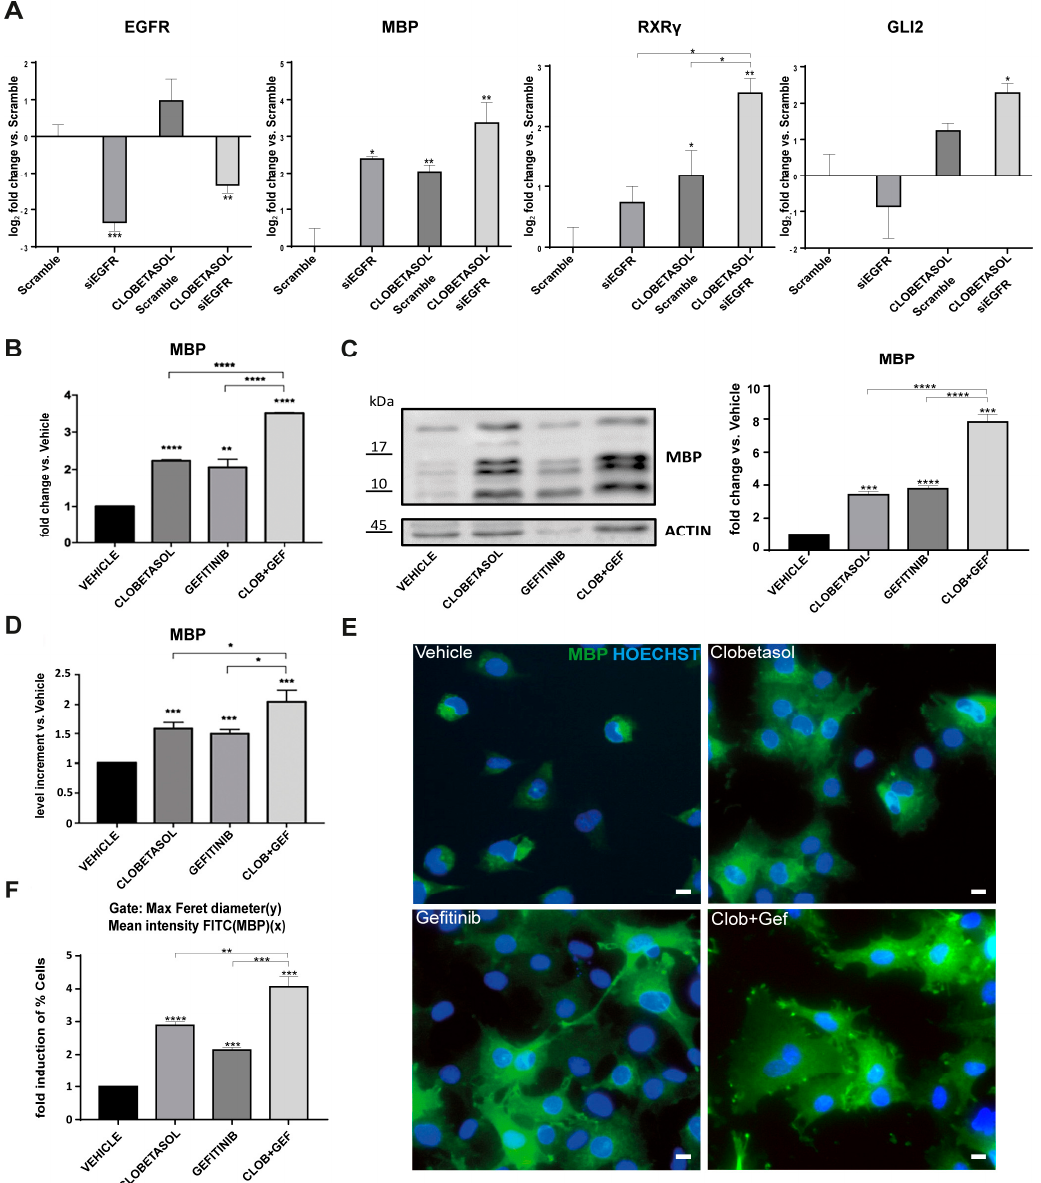
Figure 3. Epidermal growth factor receptor (EGFR) gene silencing upregulates MBP expression and increases Clobetasol-mediated Oli-neuM di ff erentiation. ( A ) qPCR analysis of siEGFR Oli-neuM cells versus control (siScramble) in untreated or Clobetasol-treated Oli-neuM. The graphs show gene expression levels of EGFR, MBP, RXR γ and Gli2 (respective panels) after 48 h treatment. Data were plotted as log 2 fold change versus control (siScramble) ± SEM (n ≥ 4) Log 2 -fold changes were used to show graphically the positive and negative changes in expression in a symmetrical manner. The level of expression in the control (which equals 1) is represented as 0. ( B – F ) Comparison of 1 µ M Gefitinib or 5 µ M Clobetasol single or combinatorial drug e ff ects: ( B ) qPCR analyses of MBP gene expression under the indicated treatments versus vehicle (DM + DMSO). Data were normalized to an internal control (GAPDH) and plotted as fold change induction above vehicle arbitrarily set as 1. Data are mean ± SEM (n = 3). ( C ) Immunoblot analyses of MBP expression with the indicated treatment. Left panel: Representative immunoblot analysis using anti-MBP or anti-Actin antibody as indicated in Material and Methods; right panel: quantification of bands detected in immunoblots (n = 3 ± SEM) using ImageJ tools. Data are plotted as fold induction versus vehicle arbitrarily set at 1; ( D )